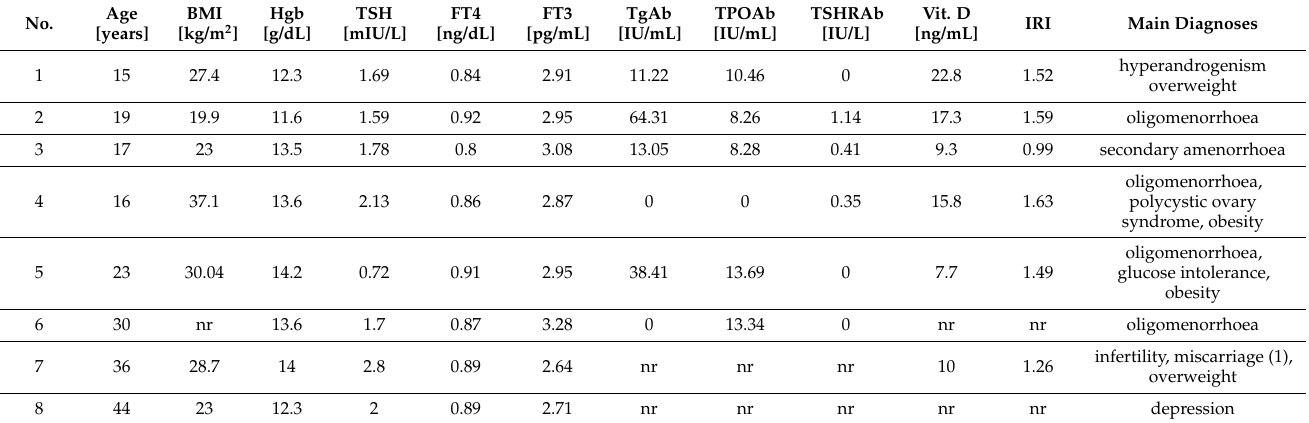
Table 1. Characteristics of particular patients with isolated hypothyroxinemia. nr: not recorded. No.